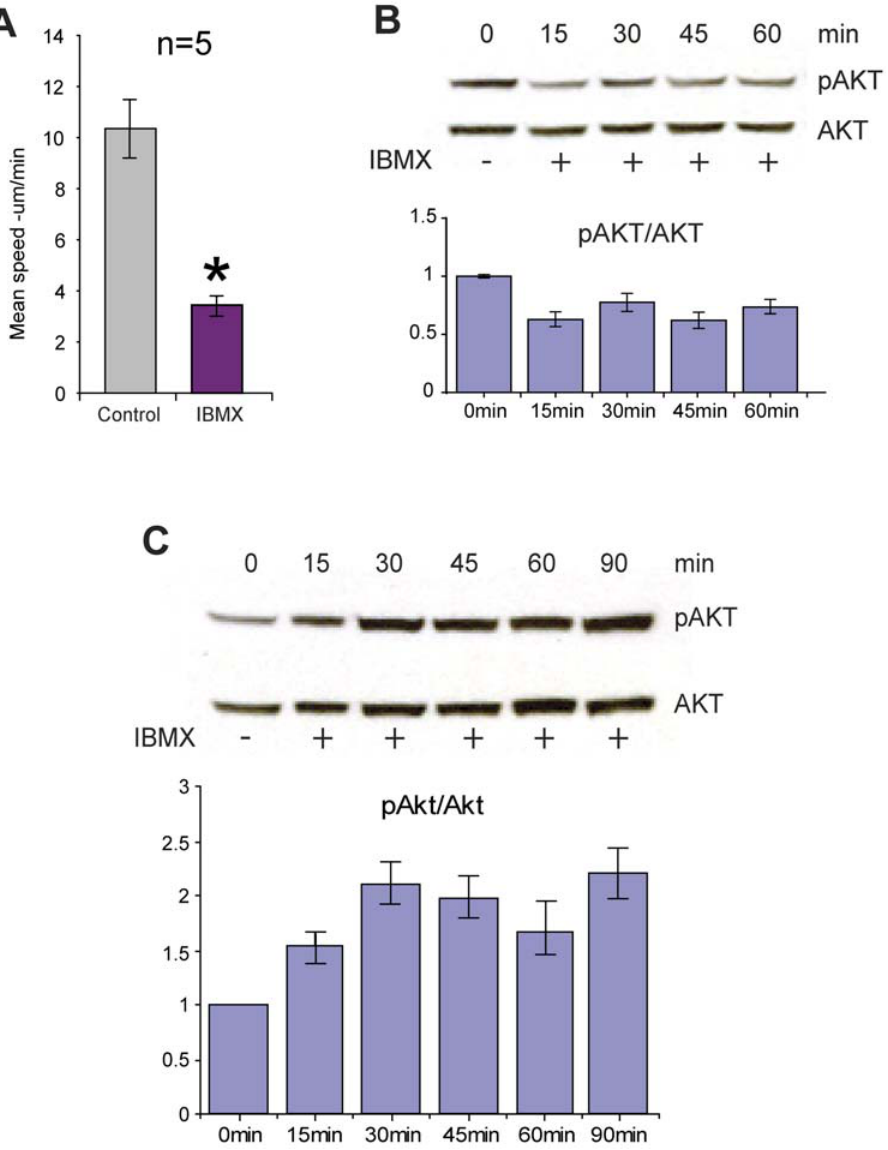
Figure 9. Dopamine and 5-HT exert opposing effects on mitochondrial movement and Akt activity (A–D). Mean speeds of directionally moving mitochondrial populations are shown at two hour intervals in A and C. Akt activity levels in cultures after treatment with DA and 5-HT are shown in B and D. Mitochondrial movement was measured following serial administration of dopamine or its receptor agonists, antagonists, and 5- HT. In these experiments, a 6 hour period of observation was divided into three two-hour intervals, each allocated for a different treatment, i.e., control (CTL), dopamine (DA), or 5-HT. A. Prior to treatment with 5-HT, hippocampal neurons were pretreated with dopamine receptor-specific agonists or antagonists, including DA, SKF38393, SCH2390, haloperidol, and bromocriptine. B. Western blot analysis shows that dopamine counteracts the effect of 5-HT on Akt activity in the presence of 5-HT. C. Prior to treatment with dopamine signals, hippocampal neurons were pretreated with 5-HT. Each mean speed value in the graph represents three repeat experiments, i.e., separately prepared cultures (n=3, paired t